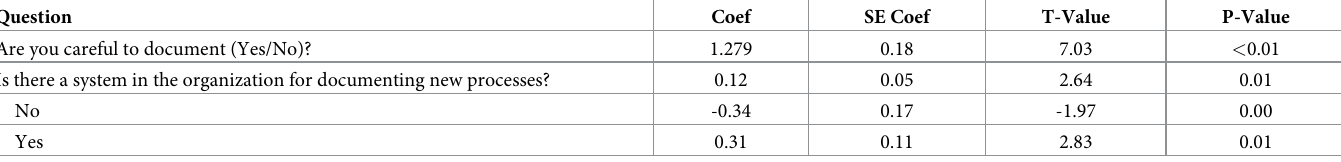
Table 5. Output results of multivariate regression